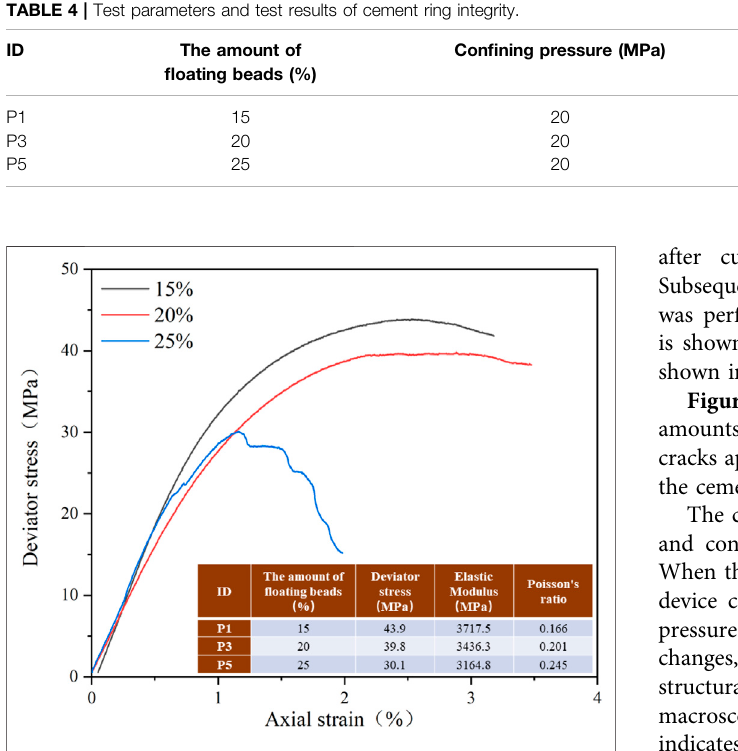
FIGURE 8 | Stress-strain curve of cement